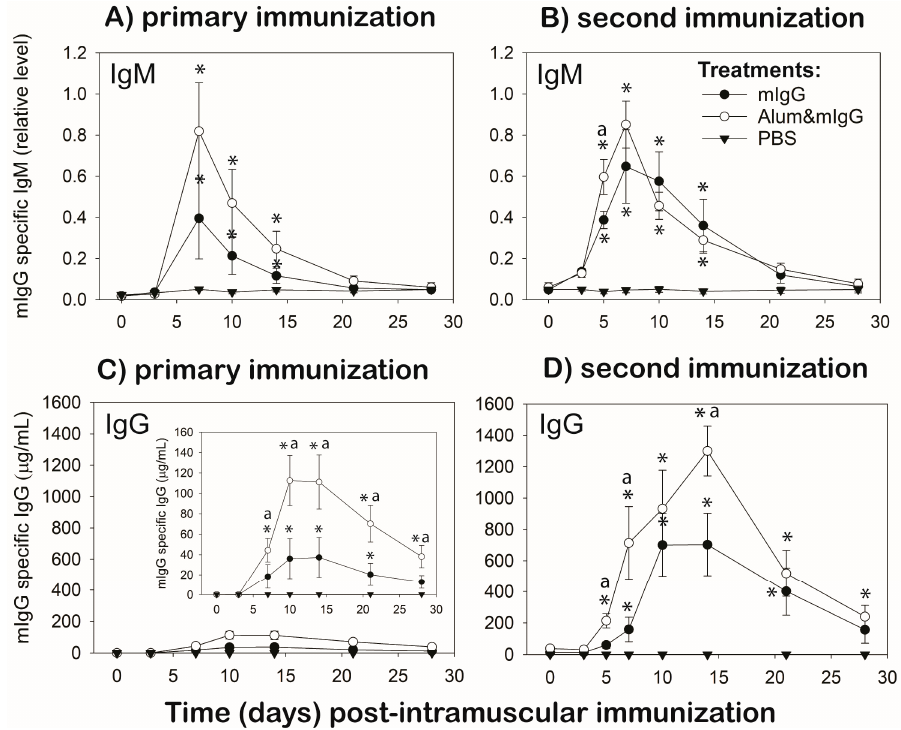
Figure 1. Primary and secondary antibody responses in chickens immunized with mouse IgG-antigen administered in PBS or mixed with alum adjuvant. ( A ) primary and ( B ) secondary mIgG-specific IgM antibody response; ( C ) primary and ( D ) secondary mIgG-specific IgG antibody response. Male Light-brown Leghorn chickens were injected i.m. with 26 µ g of mouse IgG (mIgG) in endotoxin- free (EF) PBS or mIgG mixed with 15% alum adjuvant (Alum&mIgG) in EF-PBS; four chickens per immunization treatment. Another four chickens were injected i.m. with the same volume (0.1 mL) of EF-PBS vehicle. The immunizations were conducted when the chickens were 7 and 11 weeks of age (1 ◦ and 2 ◦ vaccination, respectively). Blood samples were collected before and at 3, 7, 10, 14, 21, and 28 d post − 1 ◦ - and at 3, 5, 7, 10, 14, 21, and 28 post − 2 ◦ -vaccination. ELISA was used to determine the plasma levels of mIgG-specific IgG ( µ g/mL) and IgM (relative levels). Data are the mean ± SEM, based on four chickens per treatment. The primary IgG response is shown on the same plasma concentration scale as the secondary response and at a 10-fold lower scale range (insert). * Within a treatment group, mean values at a time-point are higher ( p ≤ 0.05) than before i.d. injection of mIgG antigen (0 d). a: indicates differences between mean values of mIgG and Alum&mIgG vaccination treatment at a time-point ( p ≤